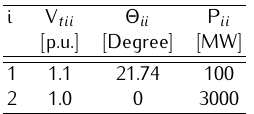
Table A.2 Operating Conditions of a Two-Machine